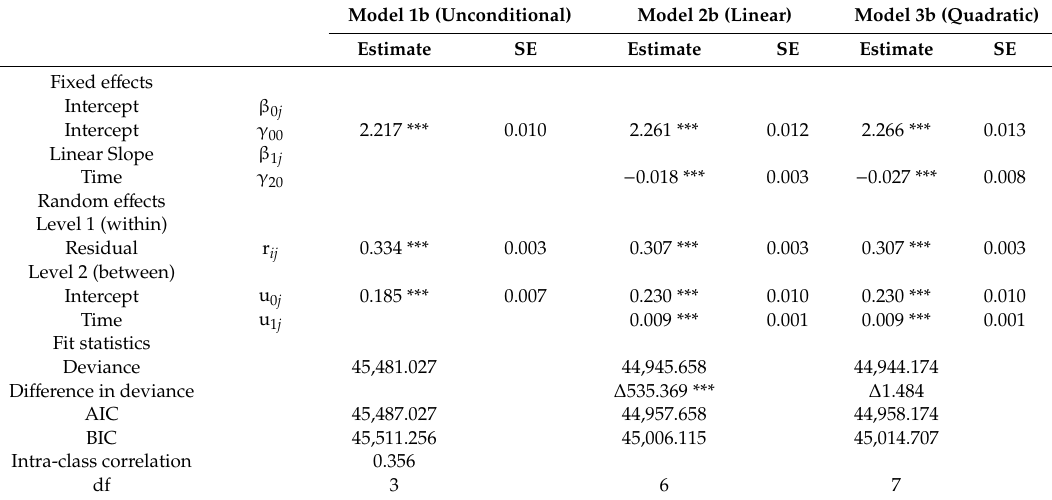
Table 4. Results of IGC models for parental psychological control (Wave